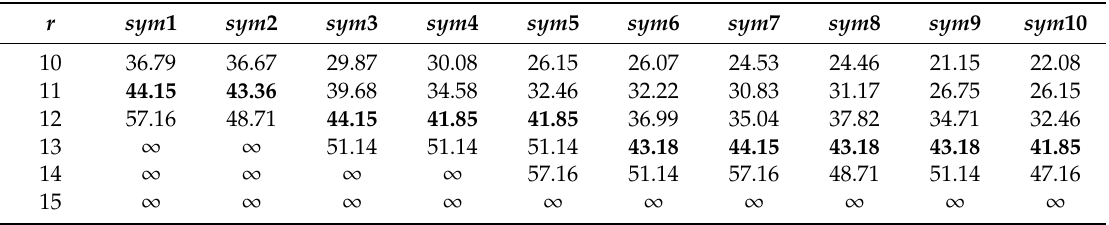
Table 4. Calculation results ( PSNR , dB) of 3D medical images (with 8 BPC) DWT by using bit-width r of symlets filters coe ffi cients.